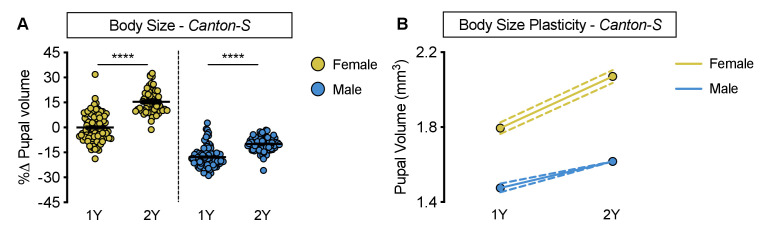
Increased nutrient-dependent body size plasticity in Canton-S females.(A) Pupal volume was significantly higher in both Canton-S (CS) females and males reared on a protein-rich diet (2Y) compared with genotype-matched females and males cultured on a diet containing half the protein (1Y) (p<0.0001 for both sexes; two-way ANOVA followed by Tukey HSD test); however, the magnitude of the nutrient-dependent increase in pupal volume was higher in females (sex:diet interaction p<0.0001; two-way ANOVA followed by Tukey HSD test). (B) Reaction norms for pupal volume in response to changes in yeast quantity in CS females and males, plotted using the data in panel A. n = 57–95 pupae. For body size plasticity graphs, filled circles indicate mean pupal volume, and dashed lines indicate 95% confidence interval. **** indicates p<0.0001; error bars indicate SEM.